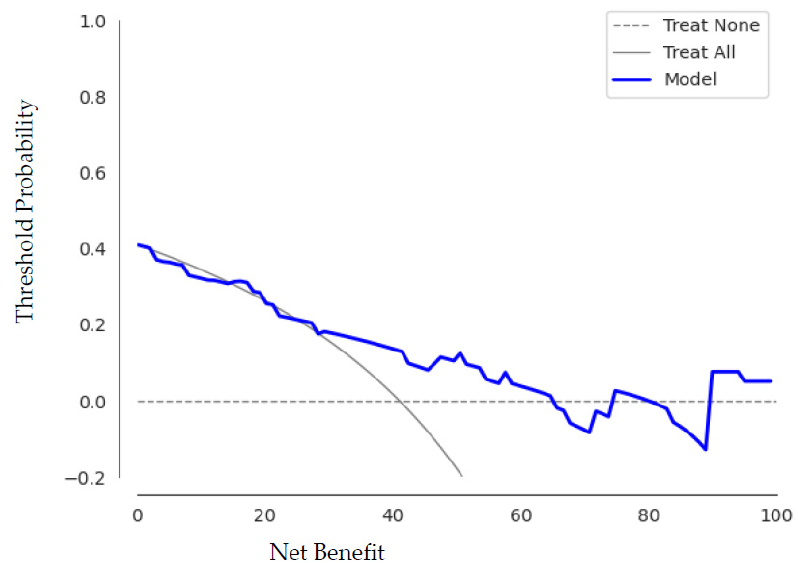
Figure 8. The decision curve analysis for the best run of the novel 3D CNN shows that within the threshold probability from 30% to 65% checking patients based on the classification model leads to a higher benefit than checking no or checking all lymphomas more frequently.